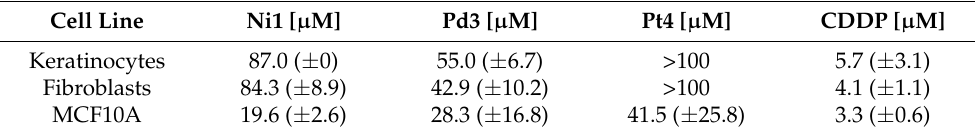
Table 5. IC 50 values [ µ M] on non-cancerous cell lines’ keratinocytes, fibroblasts and MCF10A for most active compounds of each metal class, Ni1, Pd3, Pt4, and their reference cisplatin. Cell Line Ni1 [ µ M] Pd3 [ µ M] Pt4 [ µ M] CDDP [ µ M] Keratinocytes 87.0 ( ± 0) 55.0 ( ± 6.7) >100 Fibroblasts 84.3 ( ±